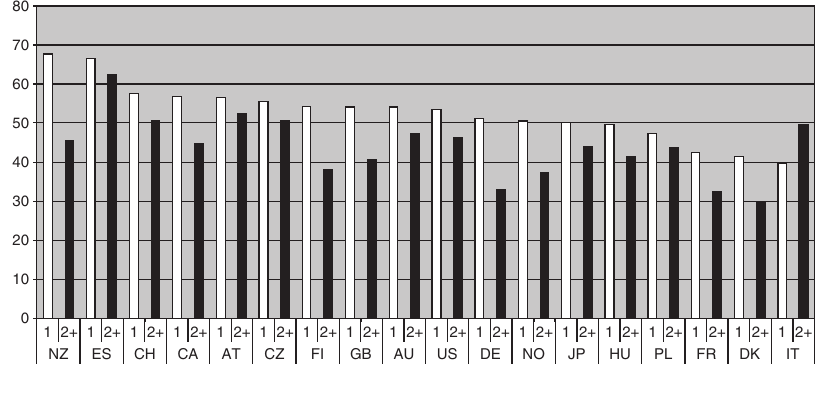
Figure 6. Proportion of respondents who see their closest friend at least once a week by household type (li v ing alone/2 (cid:3) household) and